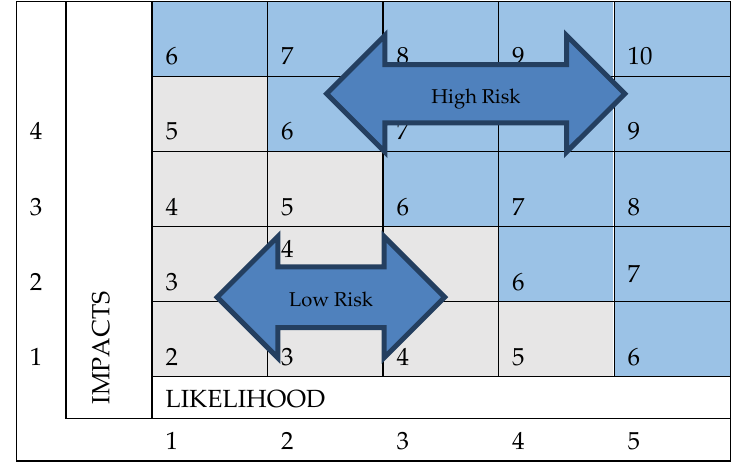
Figure 2. Risk matrix.